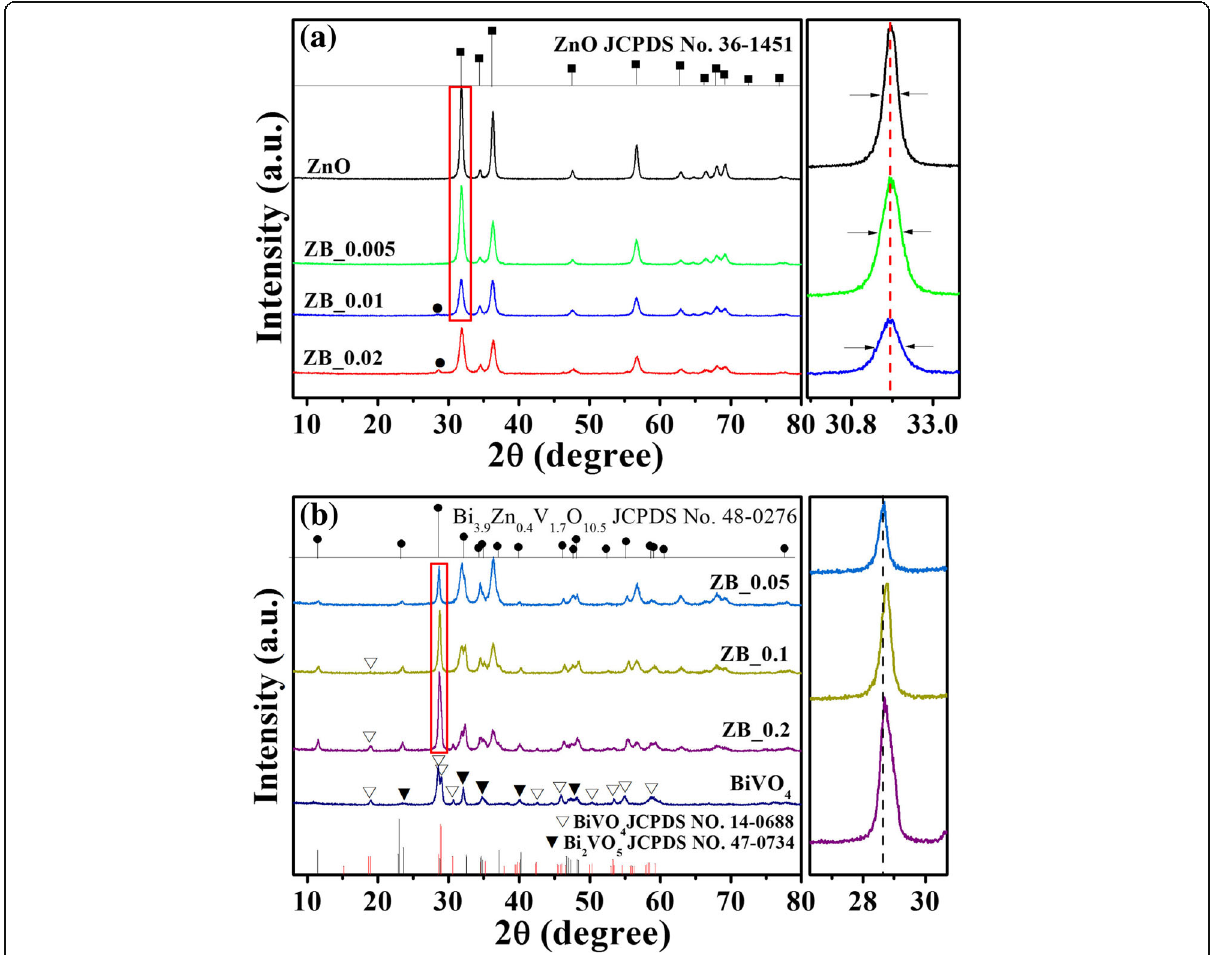
Fig. 1 XRD patterns of ZnO, BiVO 4, and BiVO 4 -modifying ZnO with different Bi/Zn molar ratios. The enlarged diffraction peaks at 31.8° of ZnO (100) for ZnO, ZB_0.005, and ZB_0.01, and the amplified diffraction peaks at 28.6° of BZVO solution for ZB_0.05, ZB_0.1, and ZB_0.2 are separately shown in a and b on the right,